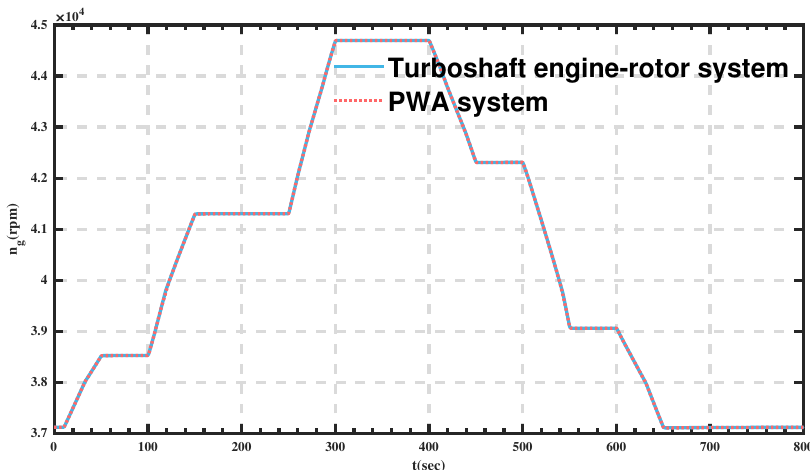
Figure 12. Speed response curves of gas turbine.